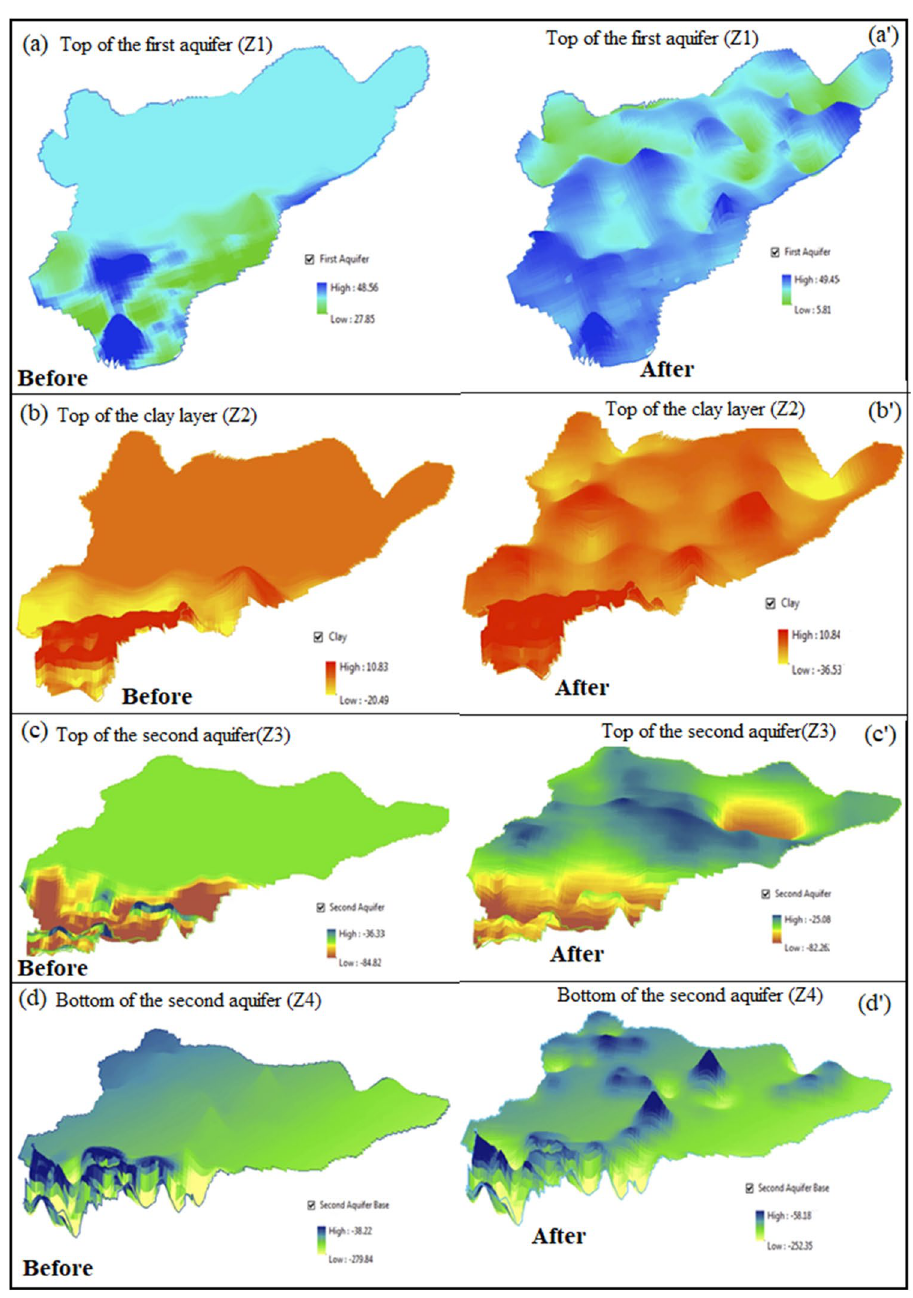
Figure 5. Comparison of 3D aquifer geometry for ( a – a ′ ) top of the first aquifer (Z1), ( b – b ′ ) top of clay layer (Z2), ( c – c ′ ) top of the second aquifer (Z3), and ( d – d ′ ) bottom of the second aquifer (Z4) (J.D: drawn this figure with the help of ArcGIS Software, Version 10.0. Redlands, CA: Environmental Systems Research Institute, Inc., 2010, http:// www. esri.